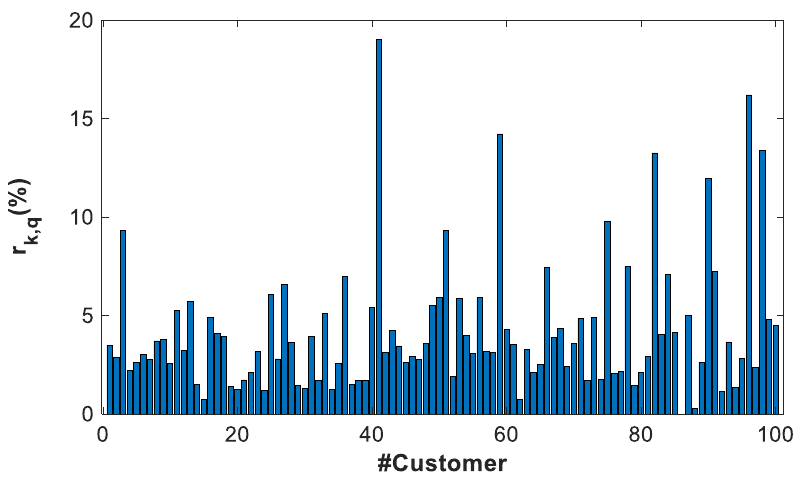
Figure 6. The partial residual of the power profiles estimator, 𝑌 𝐴𝐵𝐴𝐵 ̂ , of cluster k = ABAB. The residual is normalized by the contractual power of the cluster ABAB (P ABAB = 16.5 kW).